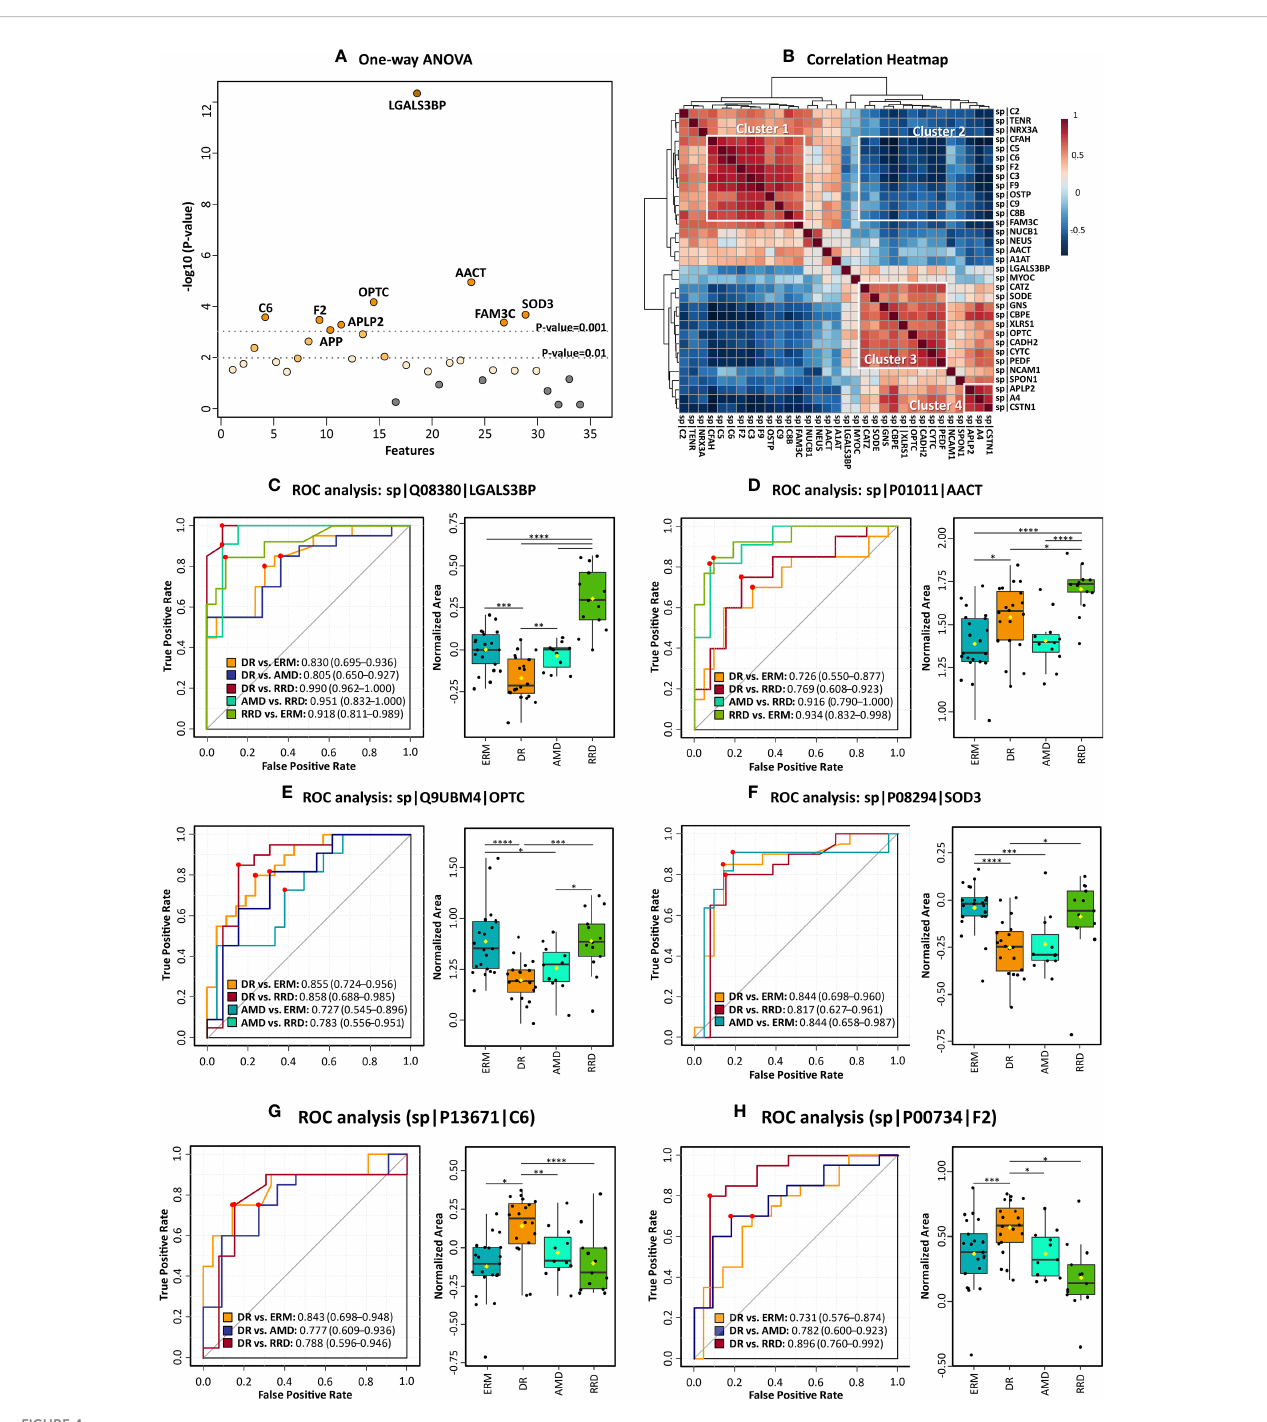
FIGURE 4 Statistical analysis of candidate vitreous biomarkers analyzed by multiple reaction monitoring was performed by MetaboAnalyst5.0 (A) One-way ANOVA plot with the more statistically relevant biomarkers highlighted with different orange grades (stronger colors represent more signi fi cant p-values). (B) Heatmap showing the correlation between different candidate biomarkers. (C – H) Results of univariate biomarker analysis of the top six candidate biomarkers in one-way ANOVA analysis, including the ROC curves for statistically signi fi cant comparisons between groups and respective box plots. Data is presented in the box plots as median ± SD and the statistical analysis was performed by two-sample t-tests, with the symbol asterisk determining the statistical signi fi cance. *p-value<0.05, ** p-value<0.01, ***q-value<0.001, and ****q-value ≤